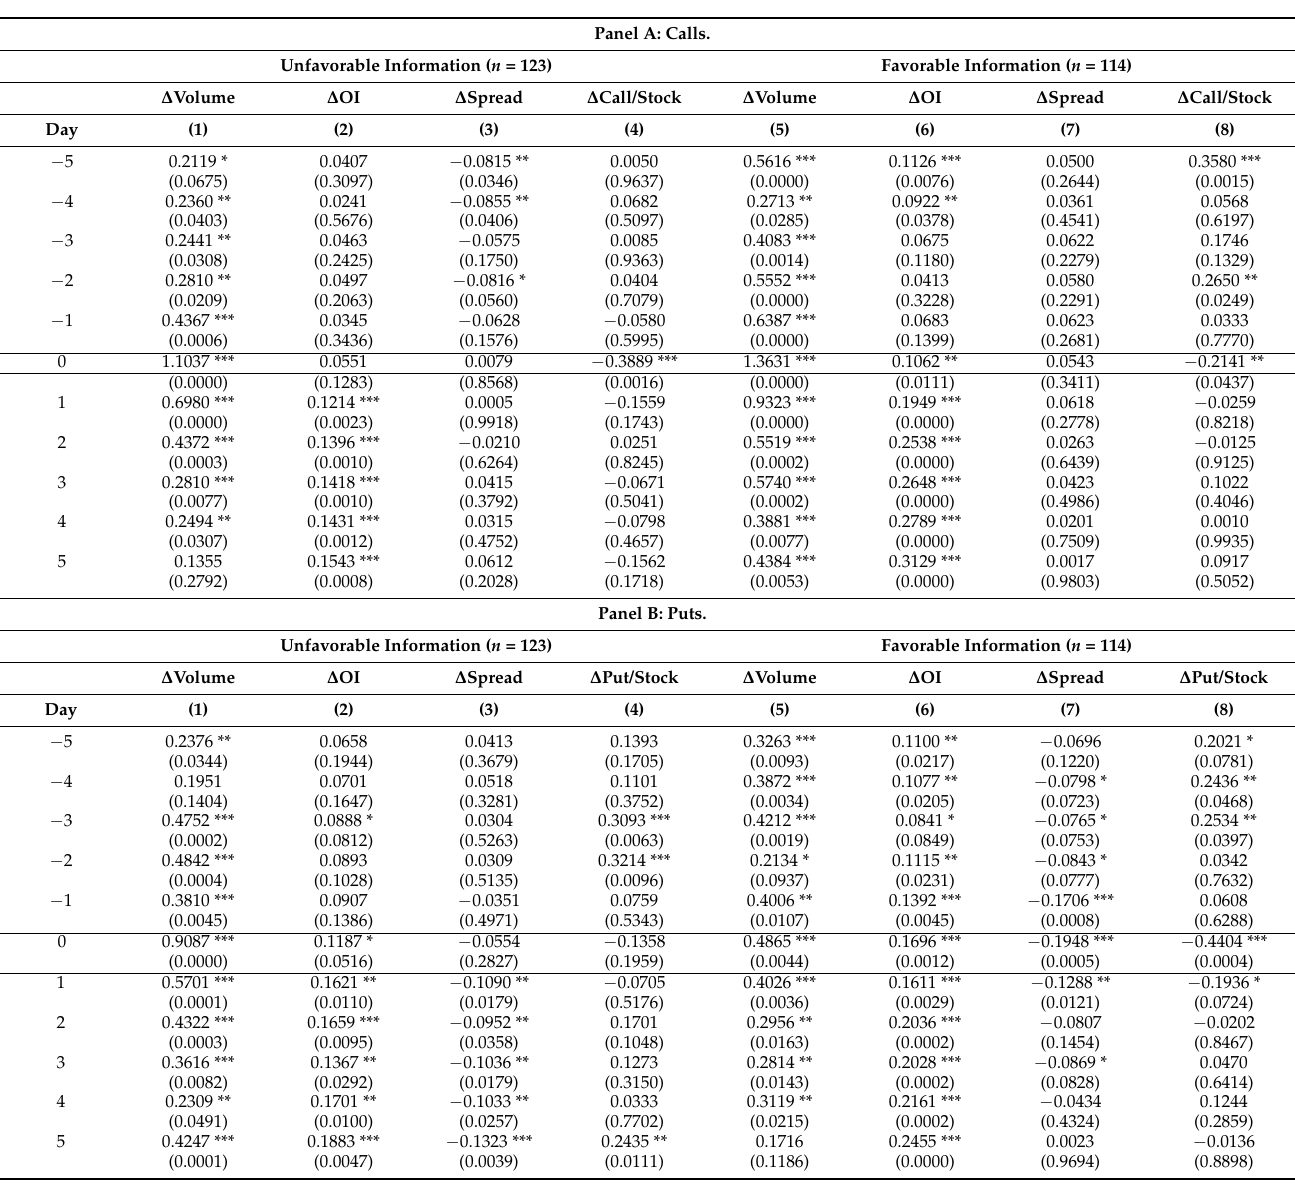
Table 4. Change in the volume, open interest, and spread for calls, puts around SEO